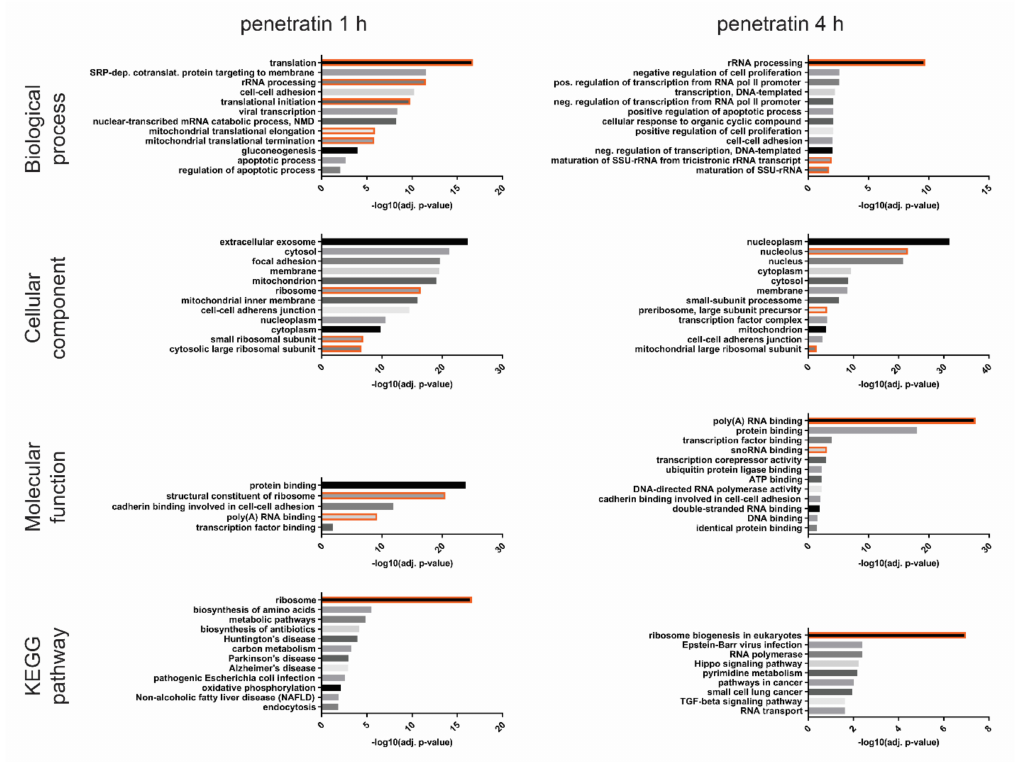
Figure 2. Gene ontology analysis of upregulated genes after 1- or 4-h treatment with penetratin. Gene ontology terms related to ribosome biogenesis and function are marked